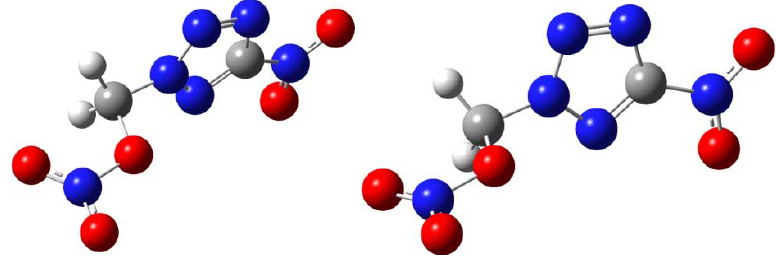
Figure 3. The optimized structure of 4 at B3LYP/6-31G(d) level.